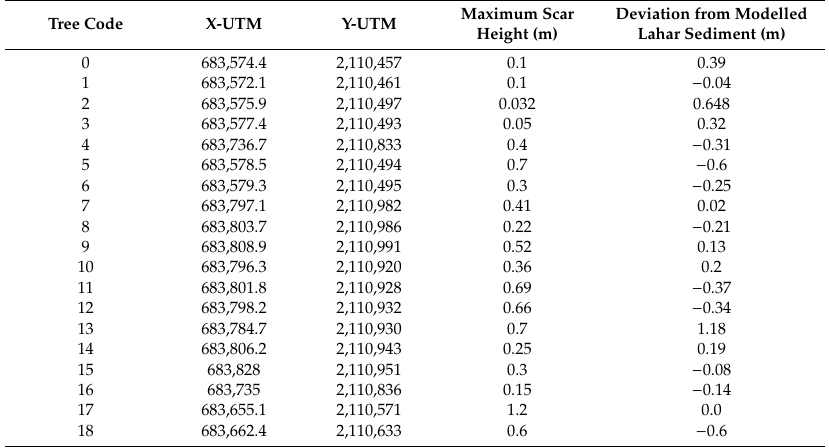
Table 2. Tree locations and absolute deviation (in m) between PSI as observed in trees and modelled flow heights. X-UTM and Y-UTM refer to the x and y values within the Universal Transverse Mercator coordinate